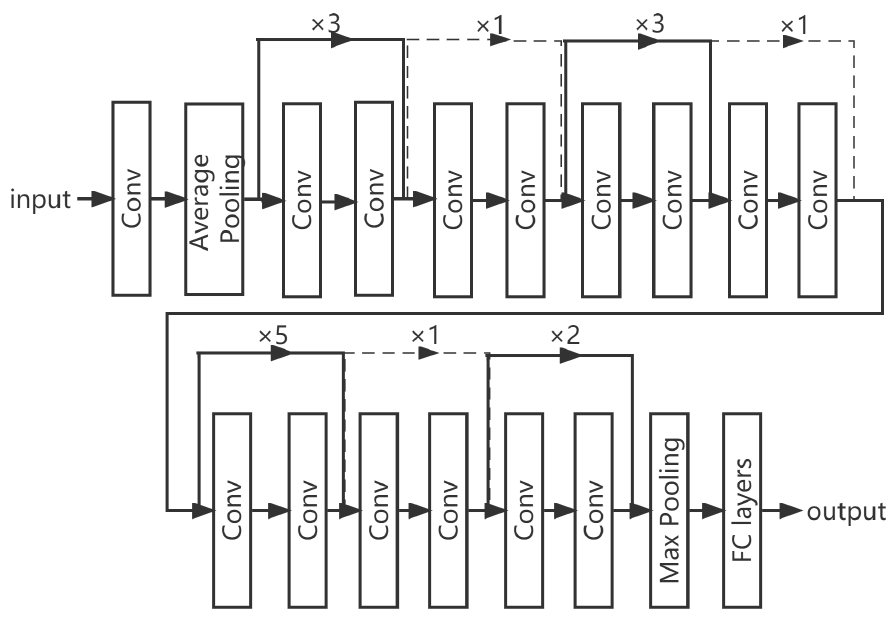
Figure 3. Network structure of